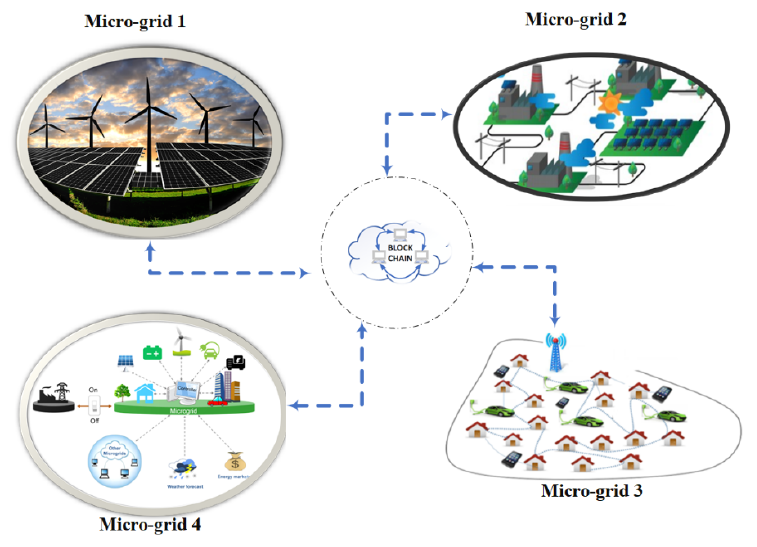
Figure 6. Blockchain architecture for MG.